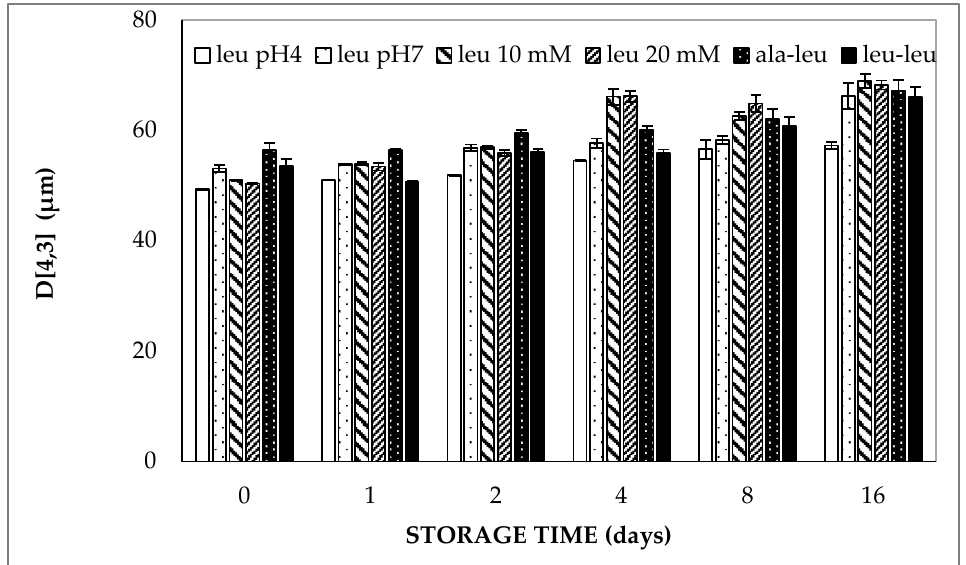
Figure 1. Volume-weighted average droplet diameter (D[4,3]) of double emulsions containing either 5 mmol/L (at pH 4.0 or pH 7.0), 10 mmol/L or 20 mmol/L L-leucine, 5 mmol/L alanine–leucine or 5 mmol/L leucine–leucine (all at pH 7.0) prepared with HOSO upon storage at 37 ◦